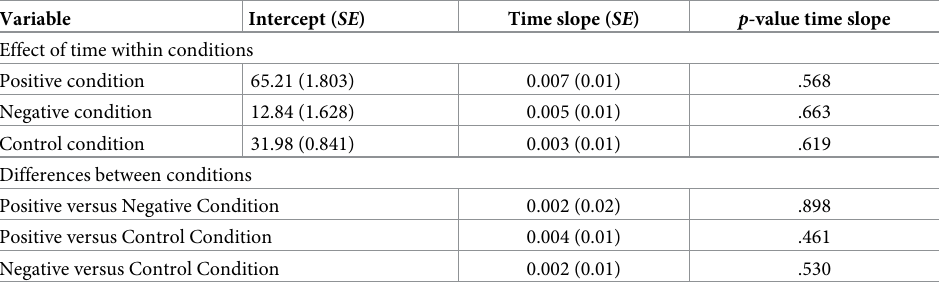
Table 2. Mixed models assessing the effect of time in each condition, and differences therein between